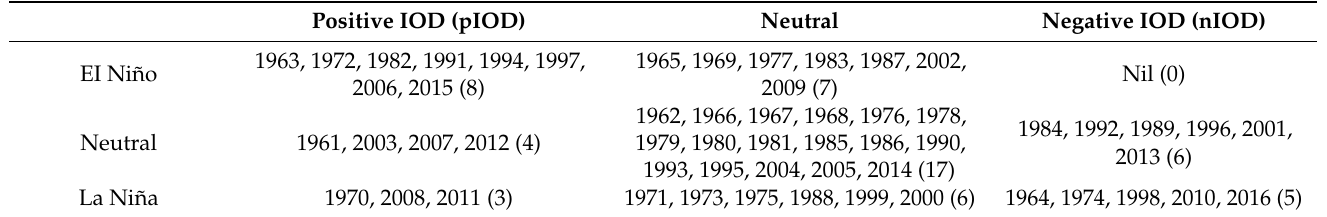
Table 1. Groupings of ENSO, IOD, and ENSO/IOD events during 1961–2016. The number of years corresponding to each grouping is shown in parentheses at the end of each